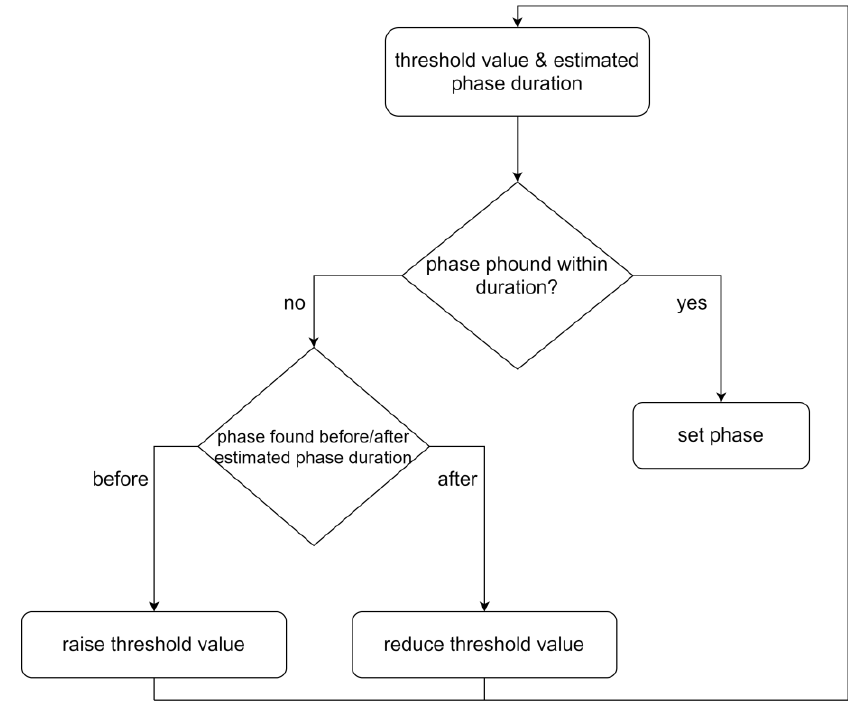
Figure 5. Flowchart of the step signal phase settings algorithm. The algorithm starts with an initial threshold value and an estimated phase duration range. If the algorithm detects a phase (slope or plateau) the algorithm stops and sets the phase accordingly. However, if the algorithm detects a phase before or after the estimated phase duration, the threshold value is raised or reduced, respectively. After that the algorithm starts again with the changed threshold value.